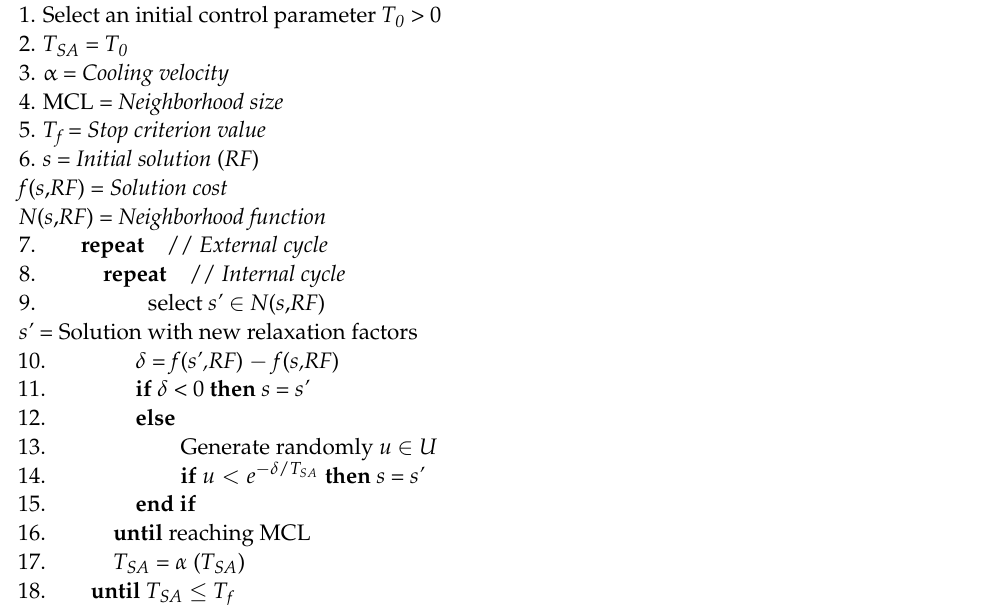
Algorithm 1. The SA-based algorithm to solve convection-diffusion and driven-cavity